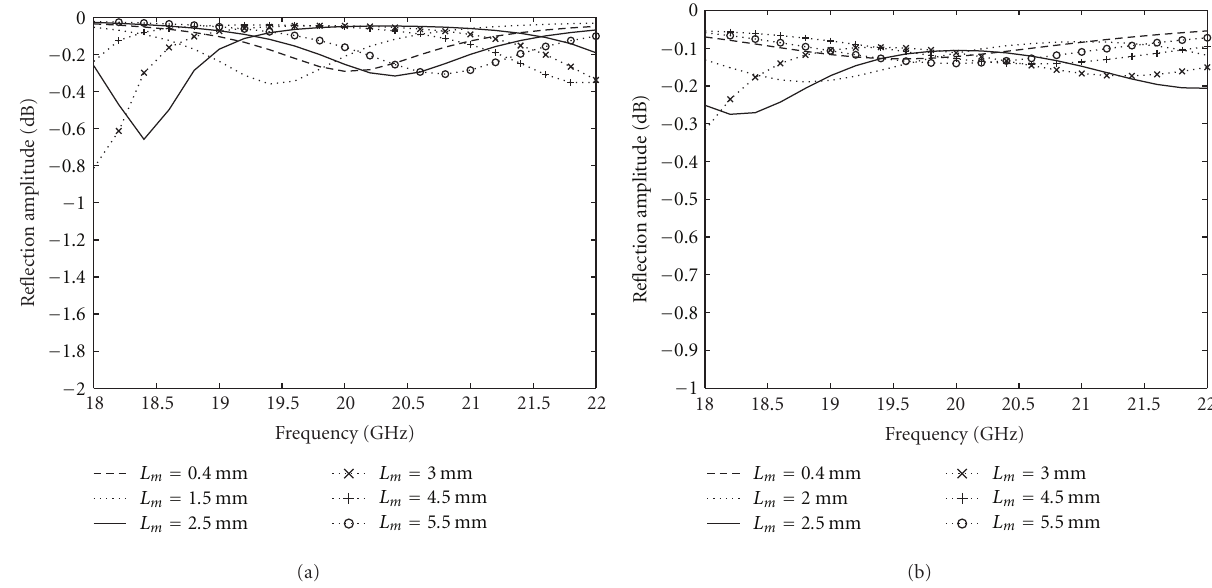
Figure 10: Calculated reflection amplitude against frequency for various tuning line length— (a) Δ x = Δ y = 0 . 6 λ ; (b) Δ x = Δ y = 0 . 4 λ .